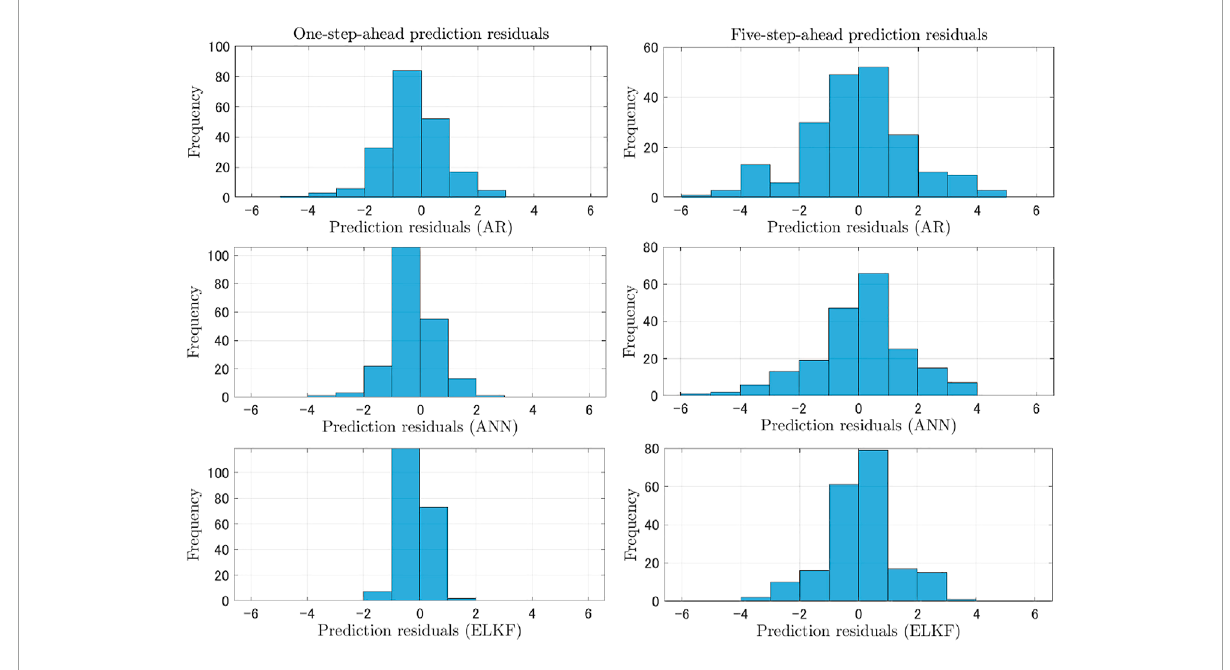
FIGURE 6 Probabilistic histograms of prediction residuals of AR, ANN, and ELKF.